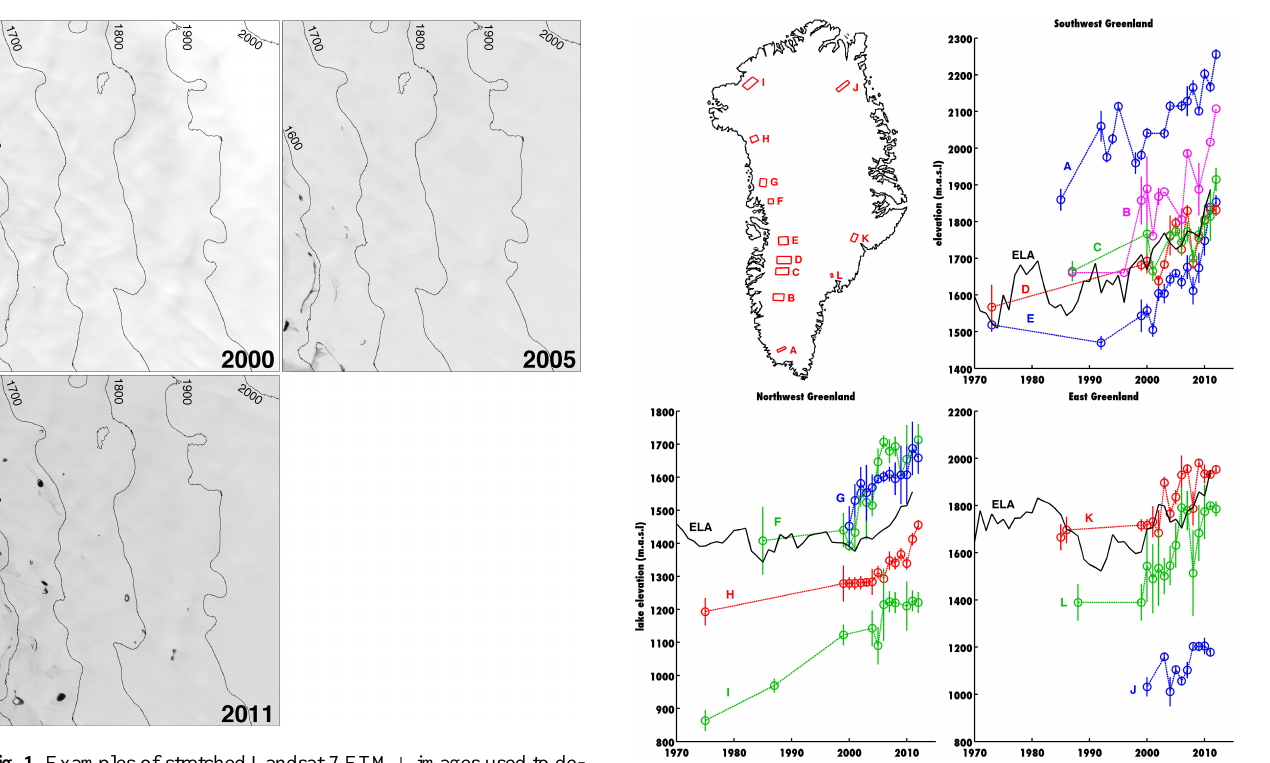
Fig. 1. Examples of stretched Landsat 7 ETM + images used to de- tect lakes from the region above Jakobshavn Isbrœ (region E in Fig. 2). Open water appears as dark patches. Elevation contours are overlain at 100m intervals. The region extends 54km in the east–west direction and 63km in the north–south direction. The im- ages were obtained on 5 August 2000, 5 August 2005 and 13 Au- gust 2011.